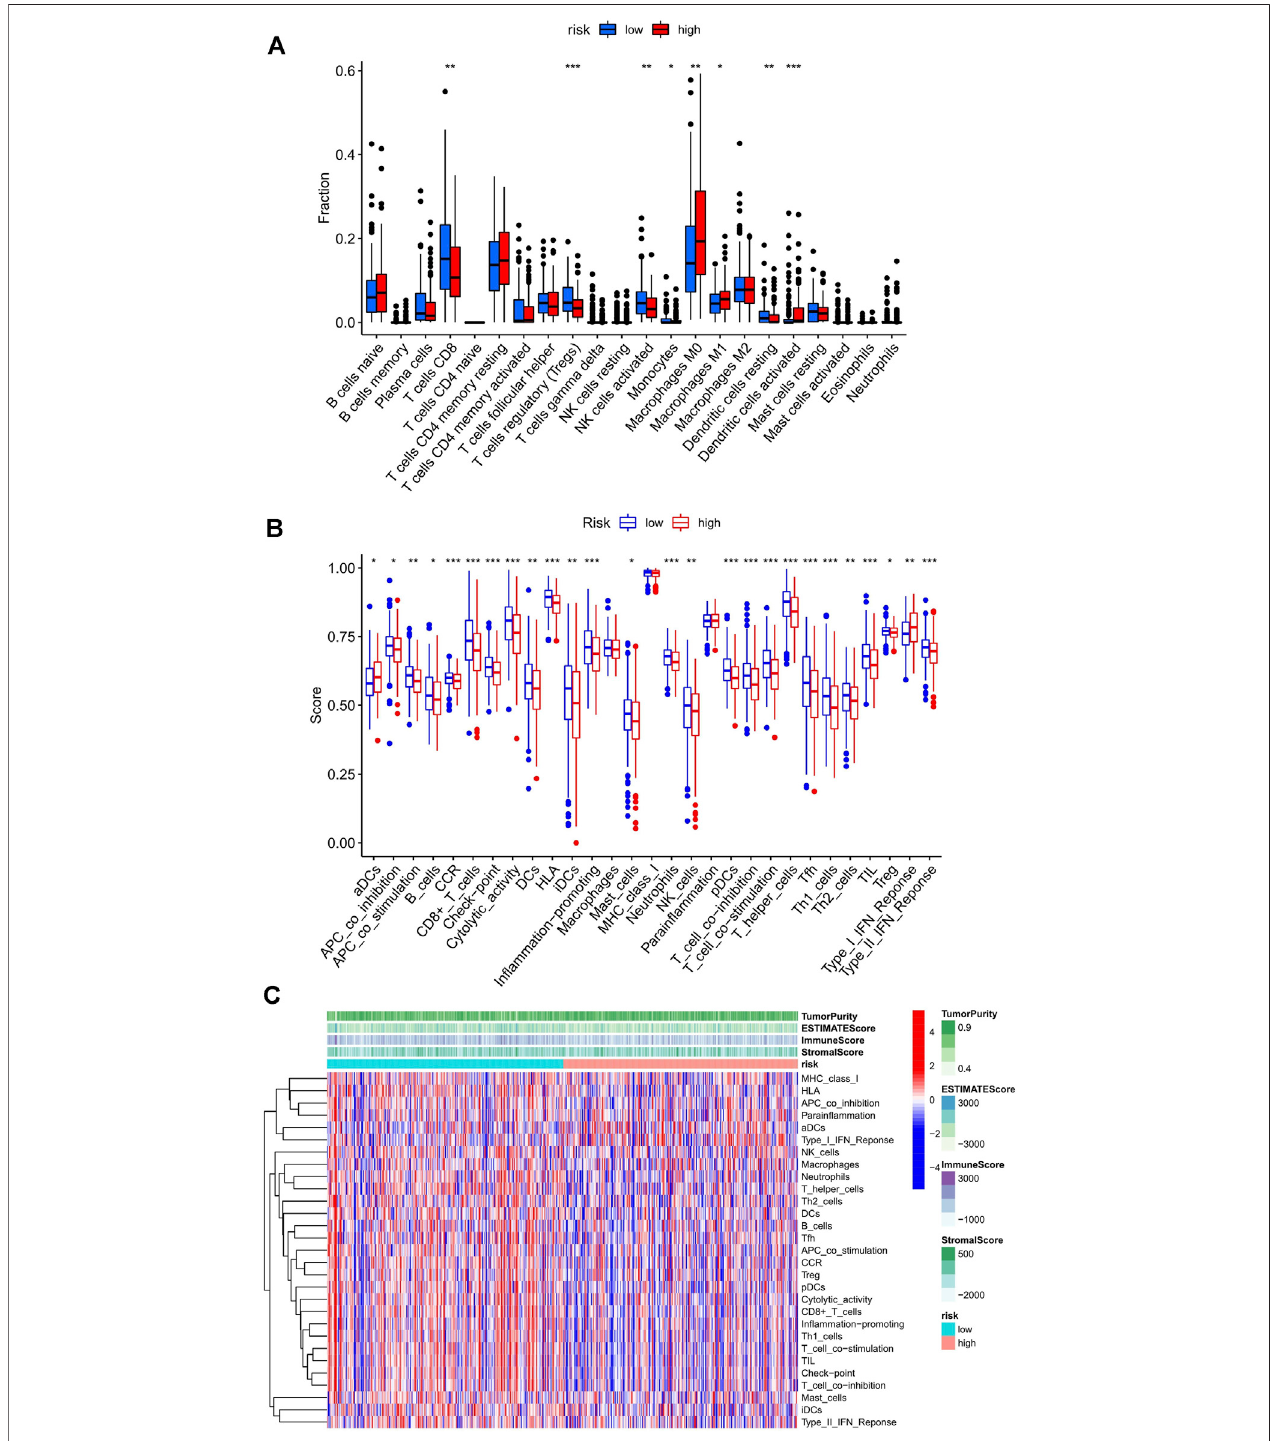
FIGURE 4 | Relationship between the risk score and in fi ltrating immune cells in the UCEC tumor-immune microenvironment. (A) The landscape of 22 types of in fi ltratingimmunecellsinthelow-riskscore( n =262)andhigh-riskscore( n =262)groups. (B) Thelandscapeof29typesofin fi ltratingimmunecellsandimmunefunction inthetwogroups.Thebottomandtopoftheboxesarethe25thand75thpercentiles(interquartilerange).Blue:lowrisk,red:highrisk.*** p < 0.001,** p < 0.01,* p < 0.05. (C) The heatmap showed a difference in the in fi ltrating immune cells between the two groups in the UCEC tumor-immune microenvironment.